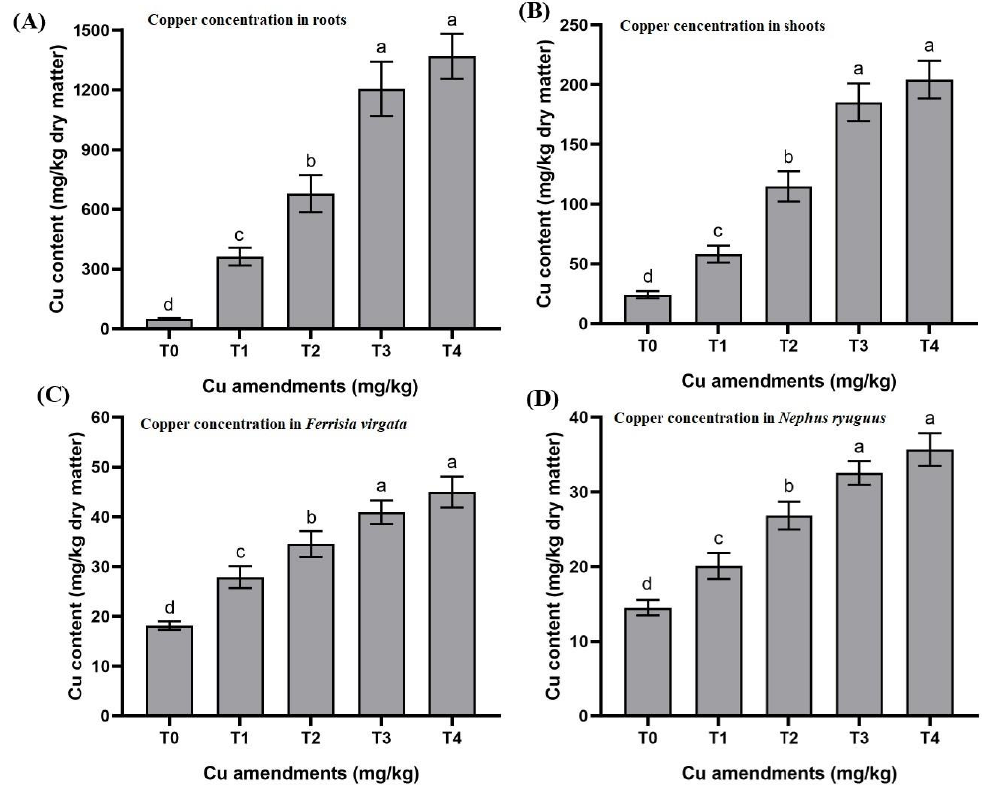
Figure 2. ( A – D ) Copper concentrations (mg/kg dry matter) accumulated in plants, mealybug and newly emerged ladybird. T0= control, T1 = 100, T2 = 200, T3 = 400 and T4 = 800 mg/kg. Each value is the mean of three replicates ± S.E. Bars with different letters are significantly different at p < 0.05.